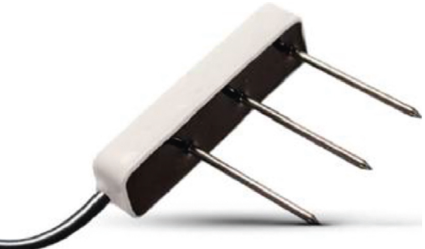
Figure 2: MS-20-type integrated temperature and moisture sensor.